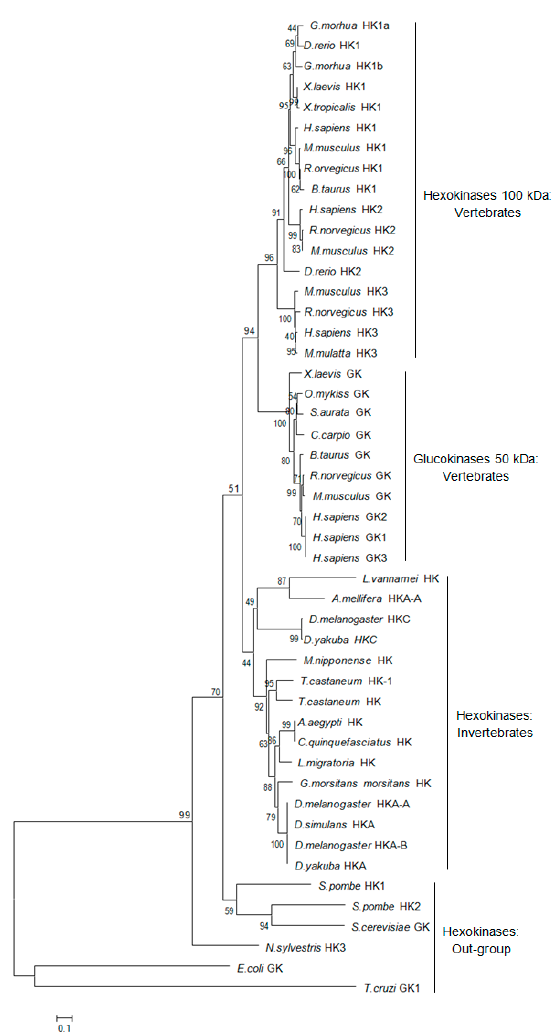
Figure 3. Phylogenetic tree based on the alignment of known amino acid sequences of hexokinase proteins. The numbers shown at the branches indicate the bootstrap values (%). Sequences used in